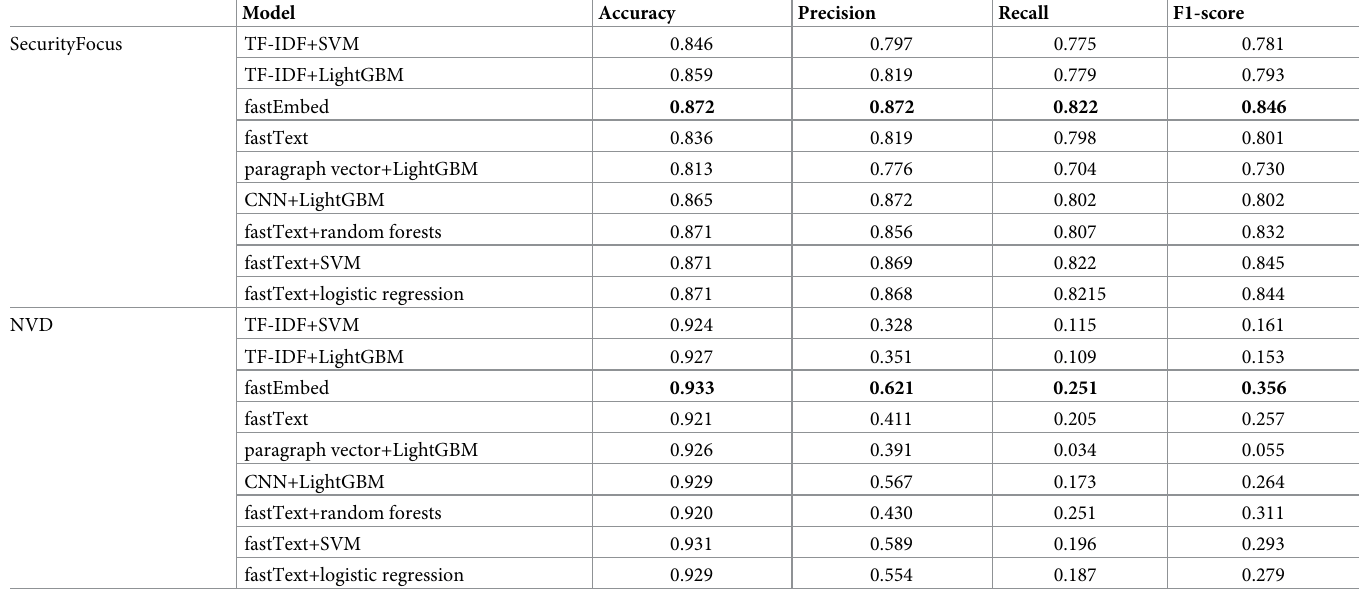
Table 5. Evaluating results.